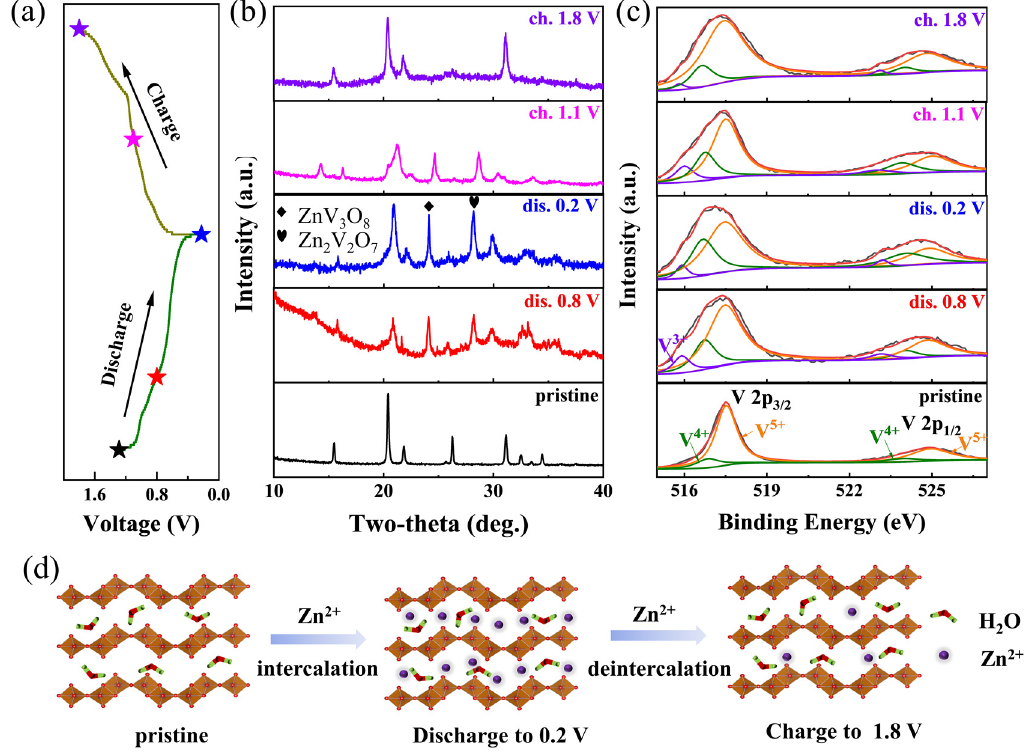
Figure 4. ( a ) Typical galvanostatic discharge–charge (GCD) profiles of the V 2 O 5 nanorods in aqueous Zn batteries. ( b ) XRD patterns and ( c ) V 2p XPS spectra of the V 2 O 5 nanorod materials at different discharge and charge states. ( d ) The schematic of ion storage mechanism upon discharging and charging.